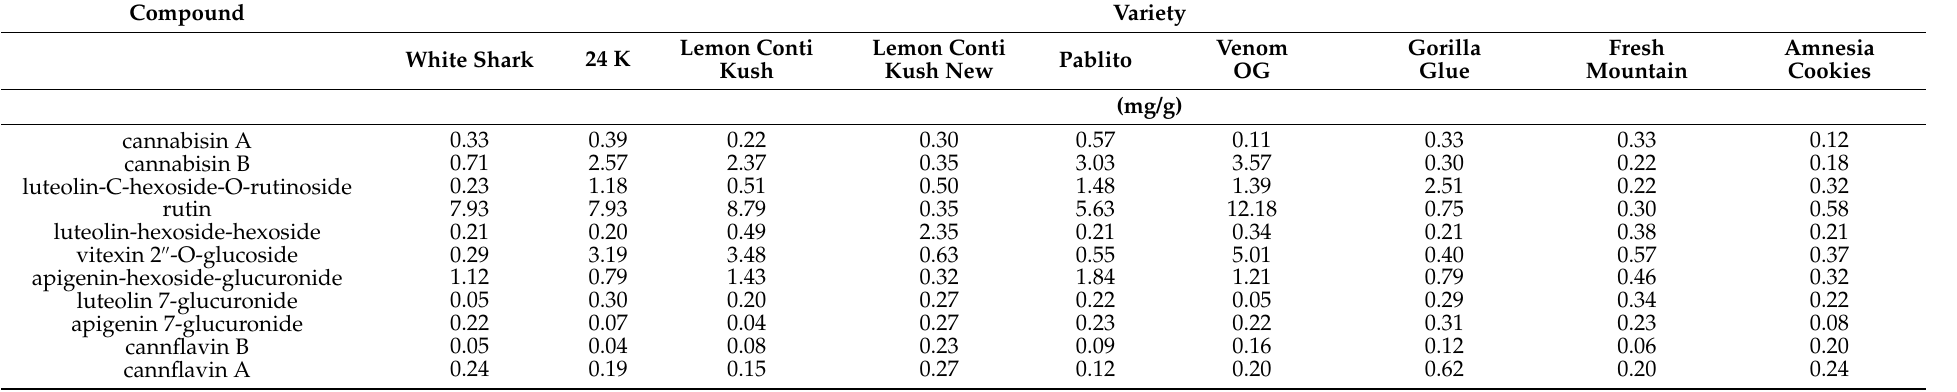
Table 8. HPLC-DAD-MS n characterization of flavonoids in